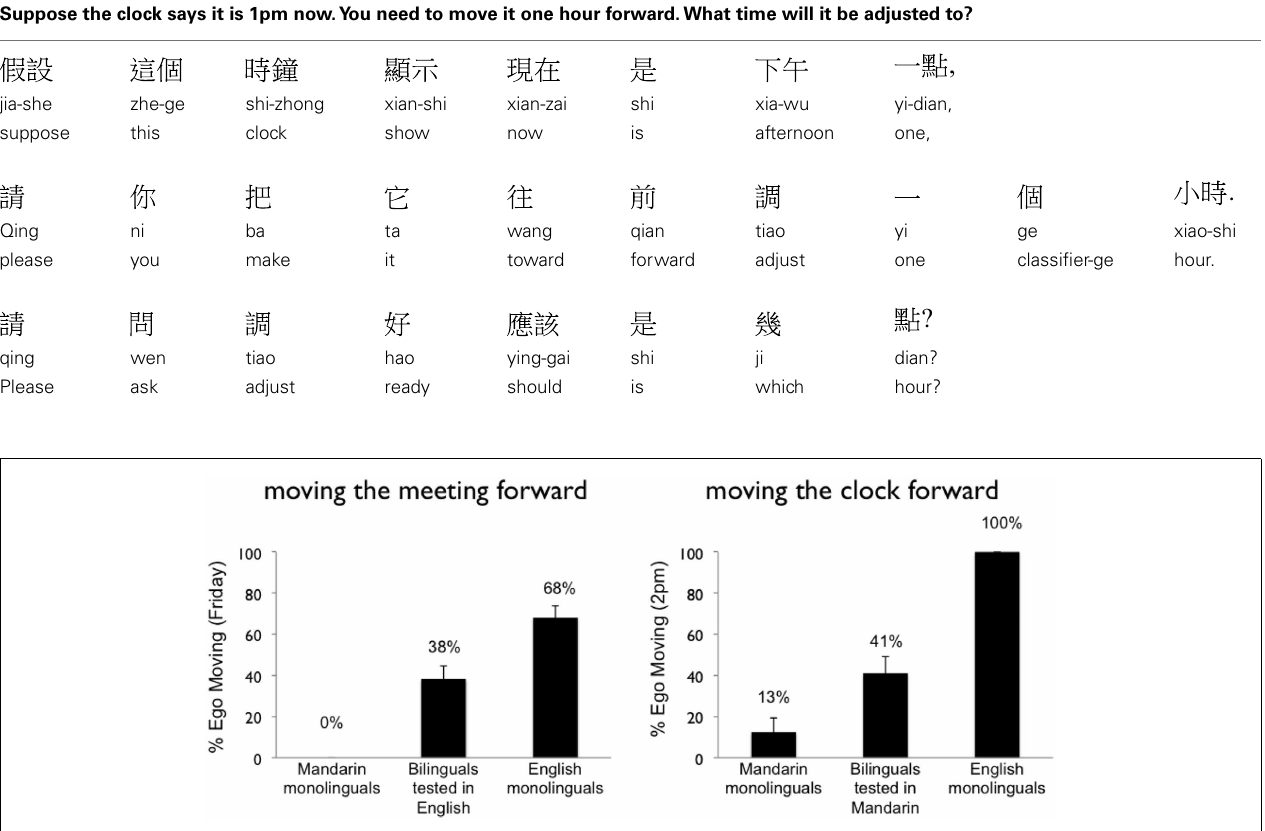
FIGURE 1 | Results of Study 1. The y -axis indicates the percentage of participants who answered that the meeting has been moved to Friday (left panel) or that the clock should be reset to 2PM (right panel), indicating an ego-moving perspective.